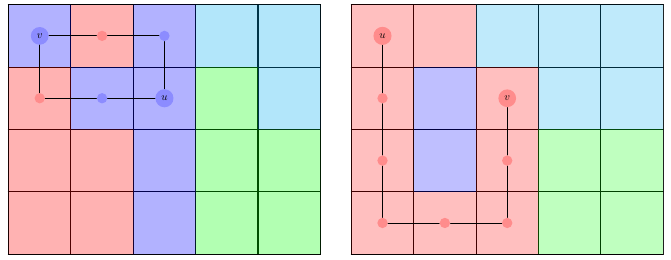
Figure 4. On the left side, a solution with path disconnected vertices (blue and red) is shown; on the right side, a solution with path connected vertices (orthogonal regions) is shown.